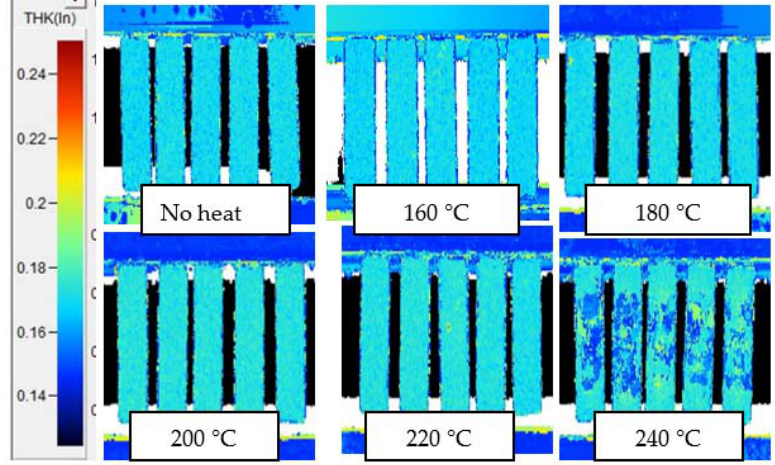
Figure A4. C ‐ scan images of samples after 1 h exposure based on time ‐ of ‐ flight to maximum back wall echo.